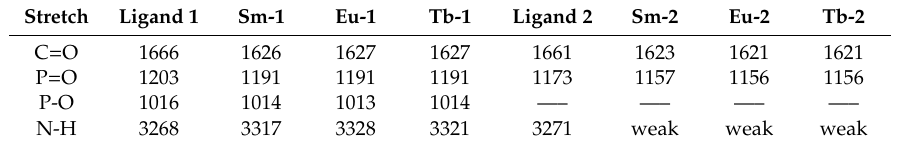
Table 1. FT-IR data of ligands 1 and the resultant Ln complexes; peak values reported in wavenumbers (cm − 1 ).